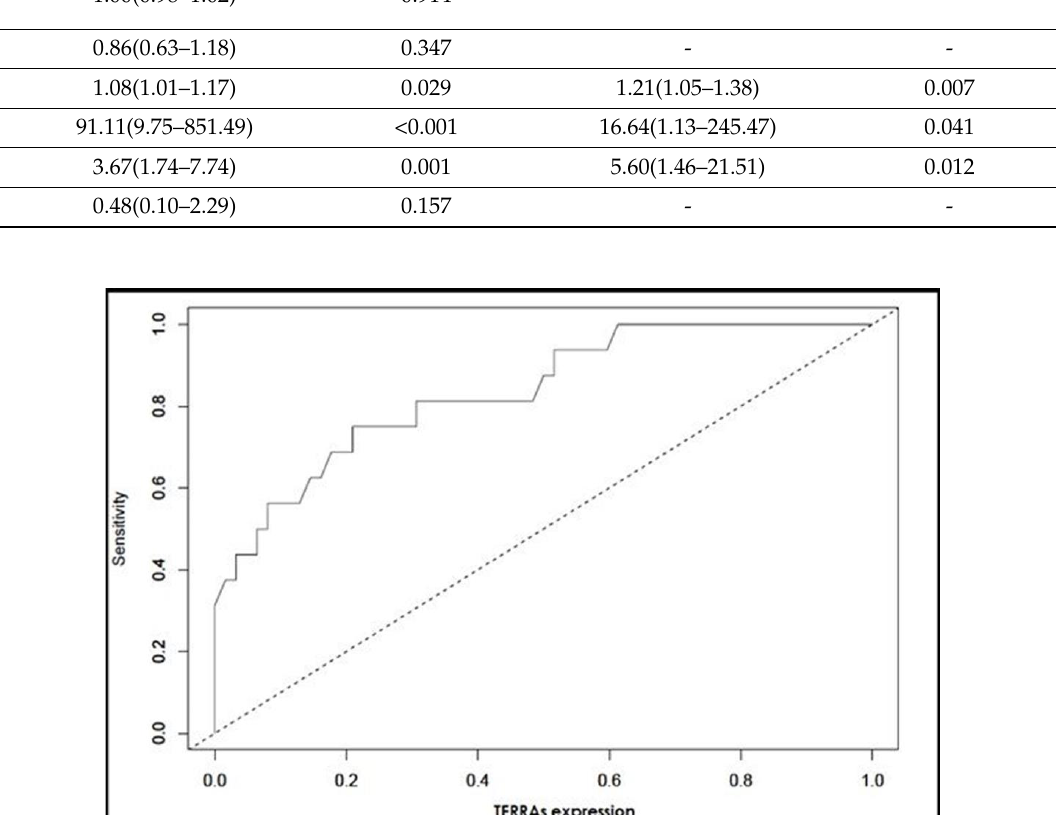
Figure 3. ROC analysis showing the diagnostic impact of TERRA levels in DNA:RNA fraction on rapid progression. Table 5. ROC analysis results for TERRA levels in predicting rapid progression in ADPKD patients; AUC: area under the curve, ROC: receiver operating characteristic, CI: confidence interval.